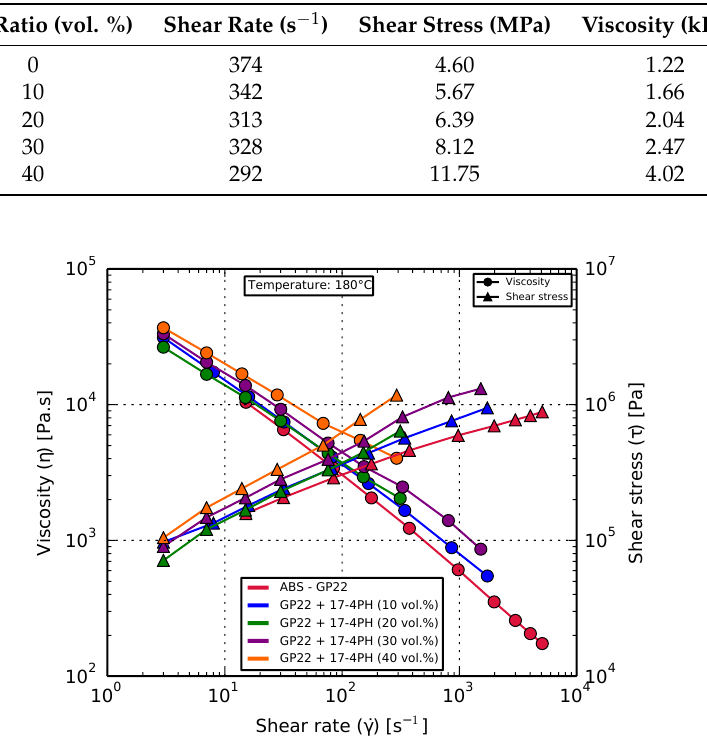
Figure 4. Rheological behavior of pure ABS compared with the composites exhibiting a shear-thinning behavior. Increase in filler content led to increased viscosity for a given shear rate.